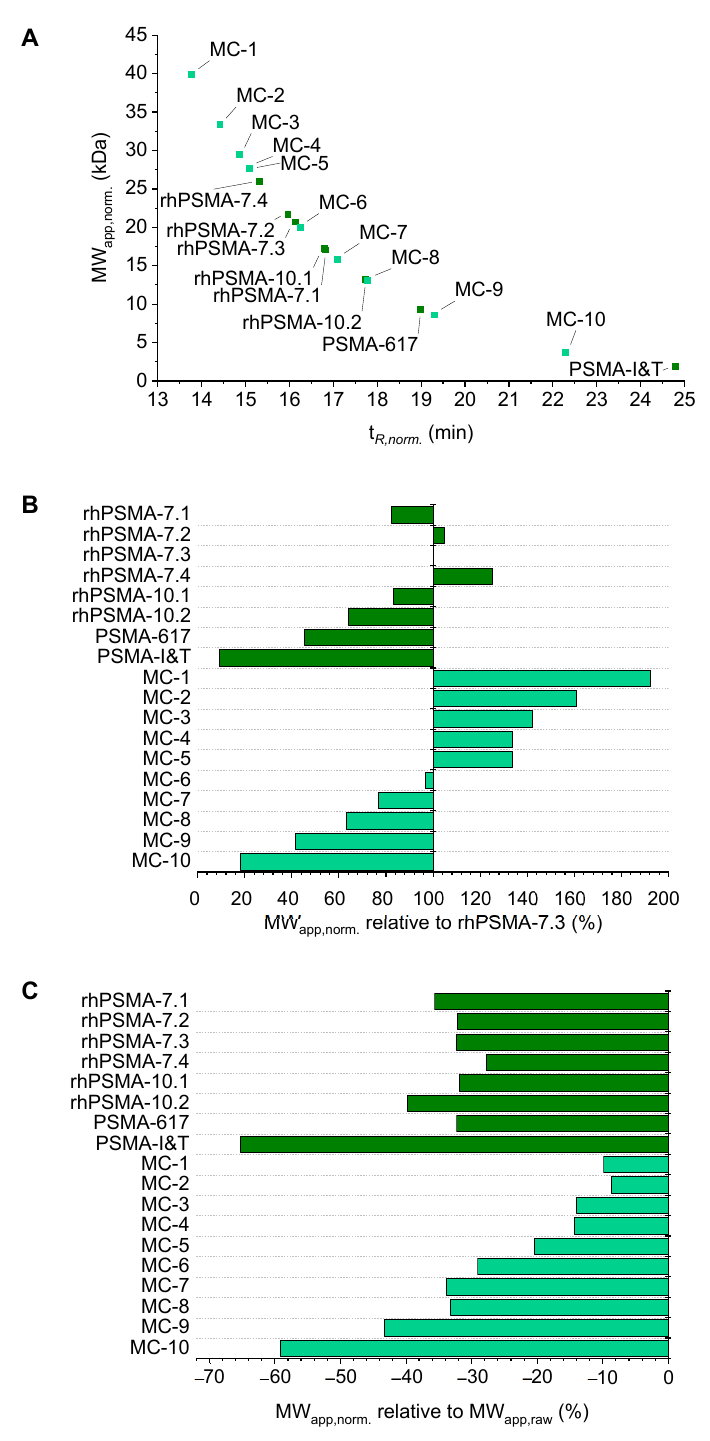
Figure 4. ( A ) Correlation between t R,norm. of radioligands and the corresponding normalized apparent molecular weight (MW app,norm. ). t R,norm. of 13.8–24.8 min corresponded to MW app,norm. between 39.9–1.9